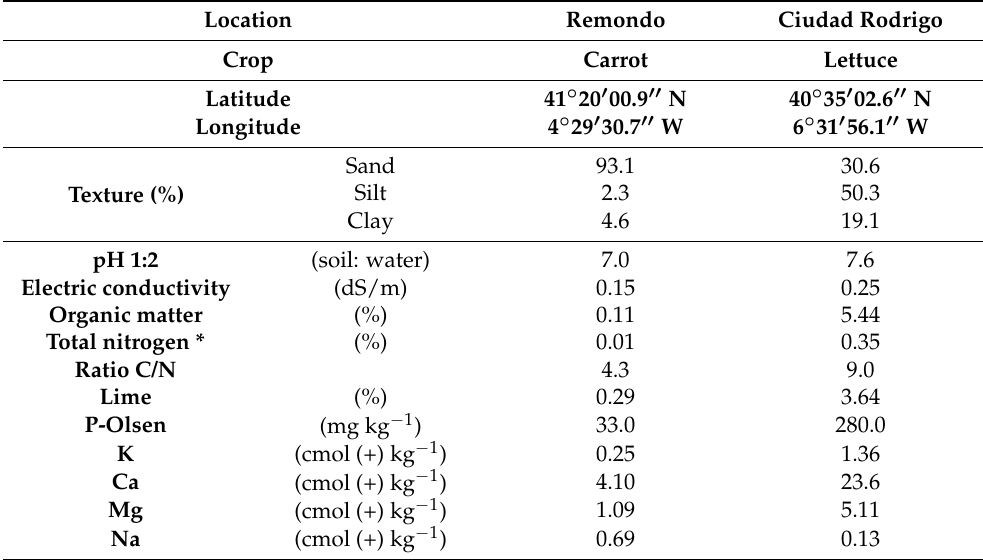
Table 1. Edaphic conditions corresponding to the fields from this study. Location Remondo Ciudad Rodrigo Crop Carrot Lettuce